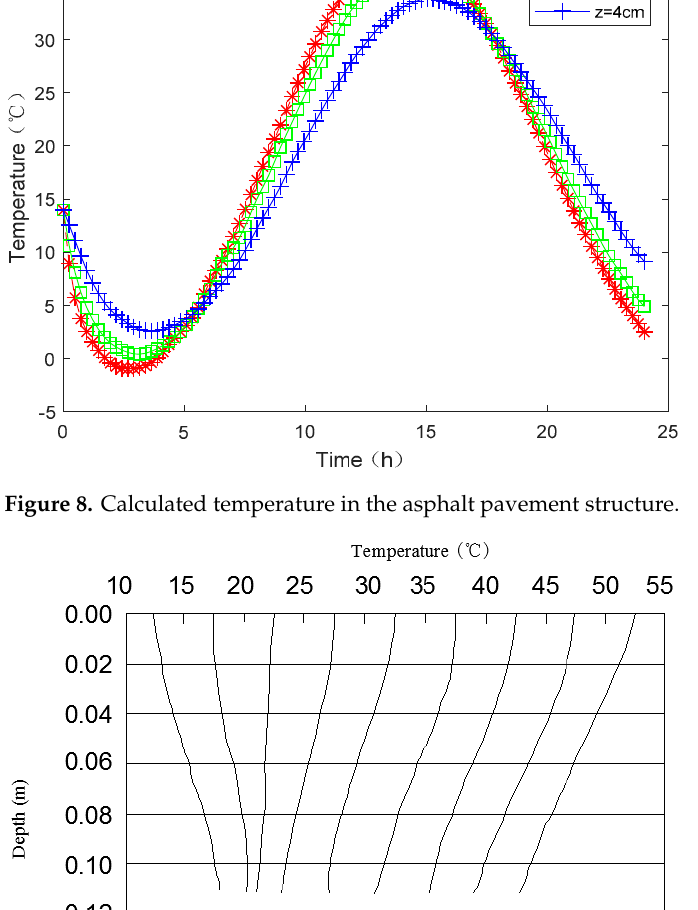
Figure 9. Temperature distribution in the asphalt pavement structure.